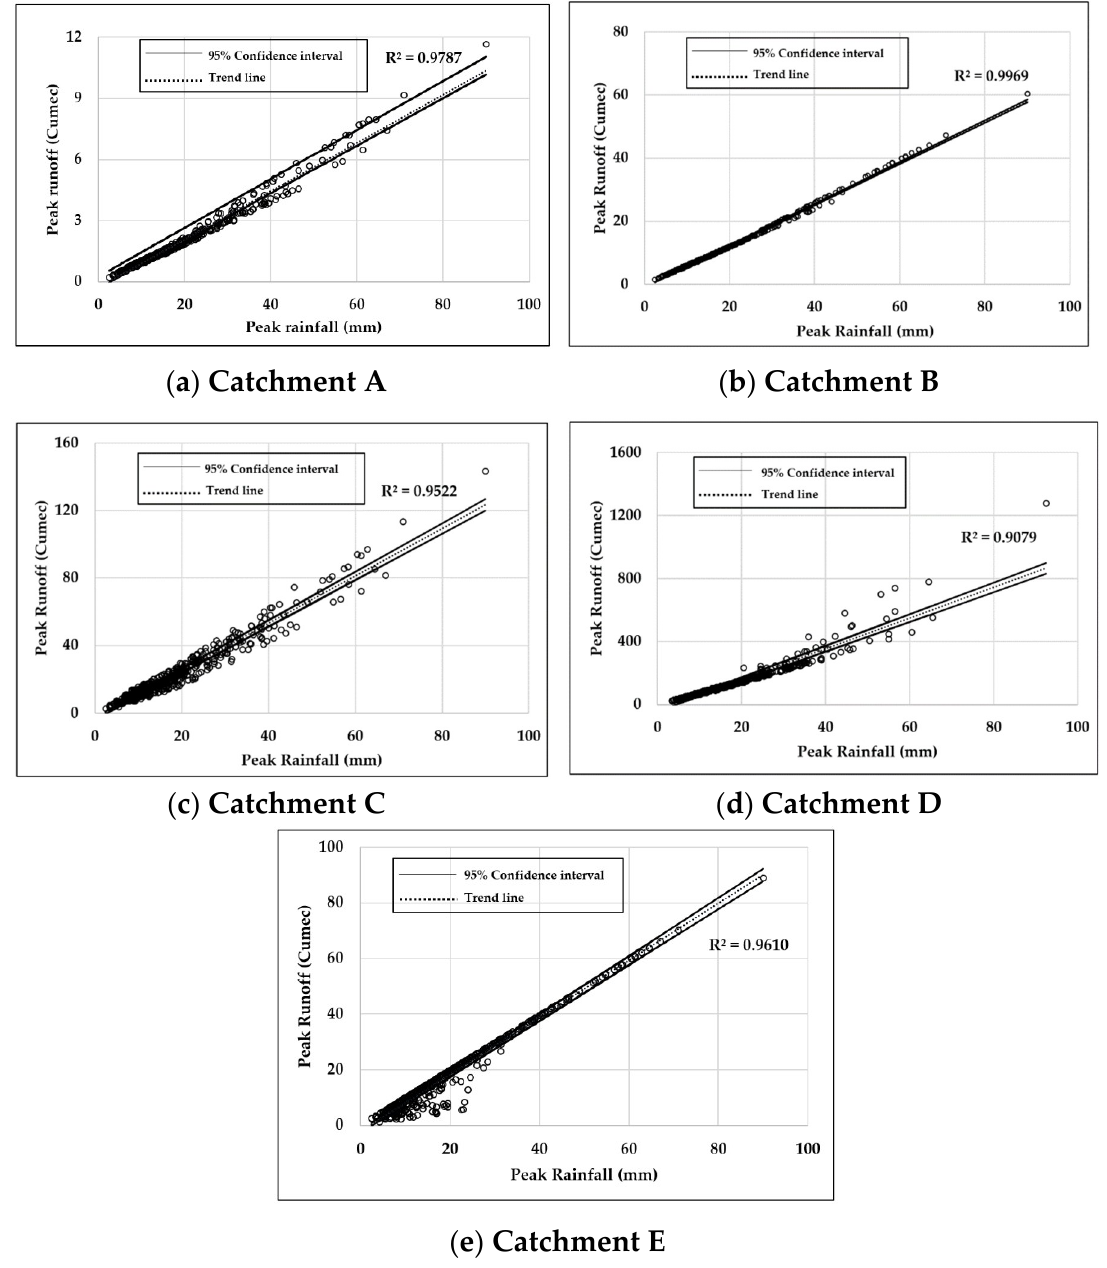
Figure 3. Regression analysis between peak rainfall and runoff in urban catchments.